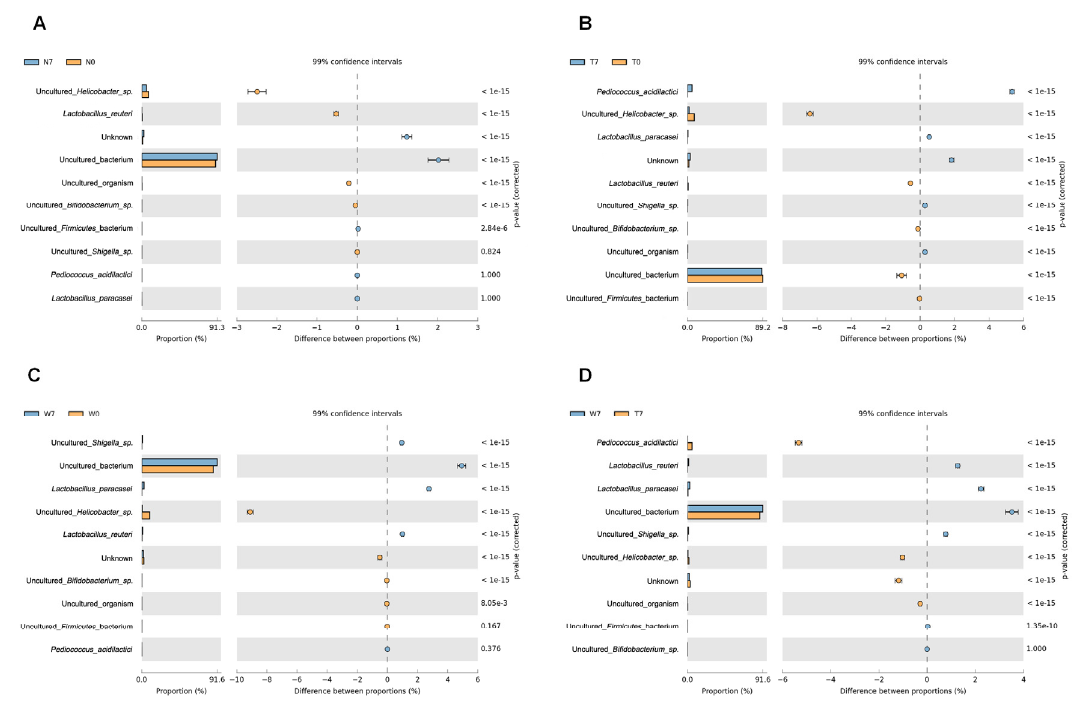
Figure 6. Comparison of bacterial species between two different groups. The difference in abundance of bacterial species between two different groups such as ( A ) N0 vs N7, ( B ) T0 vs T7, ( C ) W0 vs W7, and ( D ) T7 vs W7 were visualized by extended error bar plots implemented in STAMP program. The mean portions (%) and difference between portions were indicated with corrected p values.